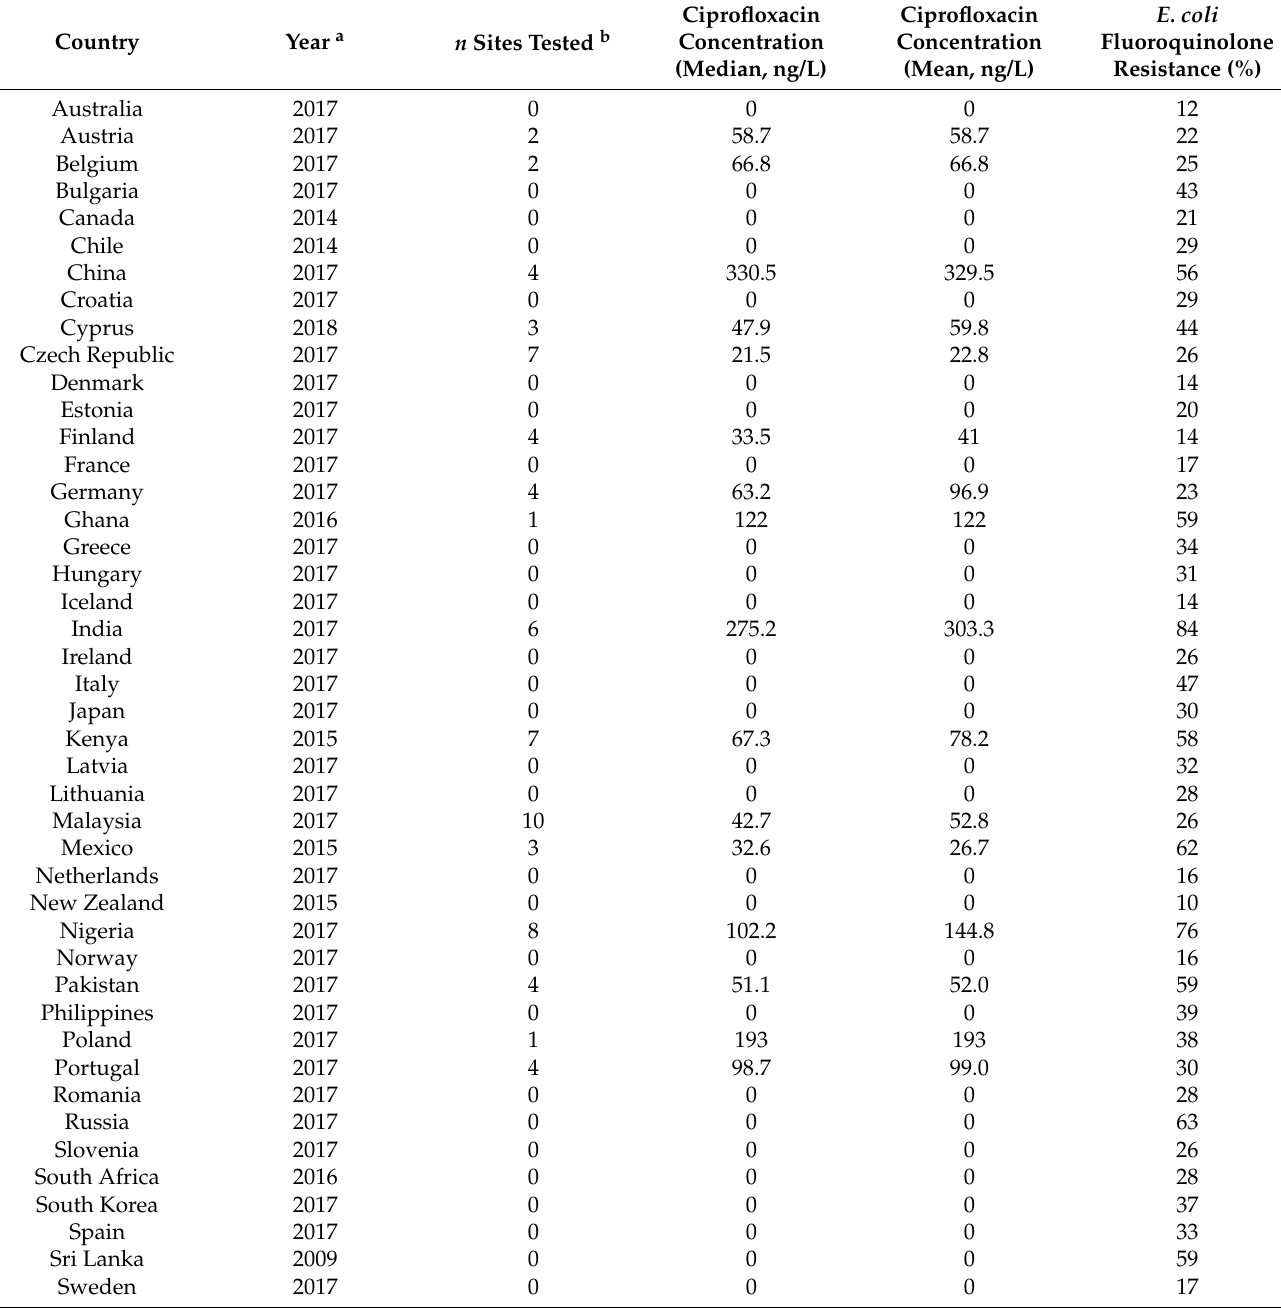
Table 1. Country-level concentration of ciprofloxacin (ng/L) in rivers and percent of Escherichia coli isolates obtained from human infections resistant to